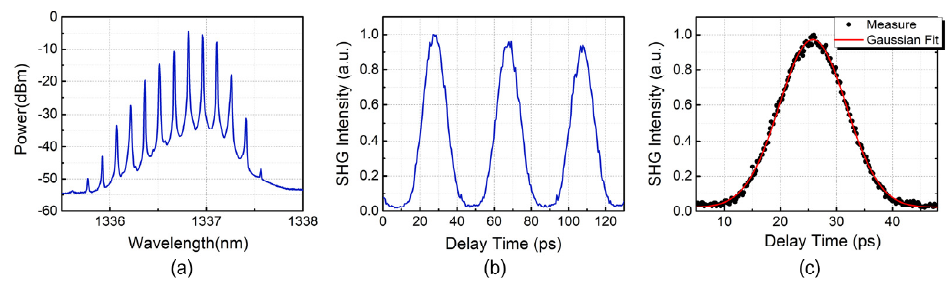
Figure 2. The 25 − gigahertz regenerative mode − locked laser with 320 − m single mode fiber ( a ) optical spectrum; ( b ) autocorrelation trace; ( c ) autocorrelation trace fitting.